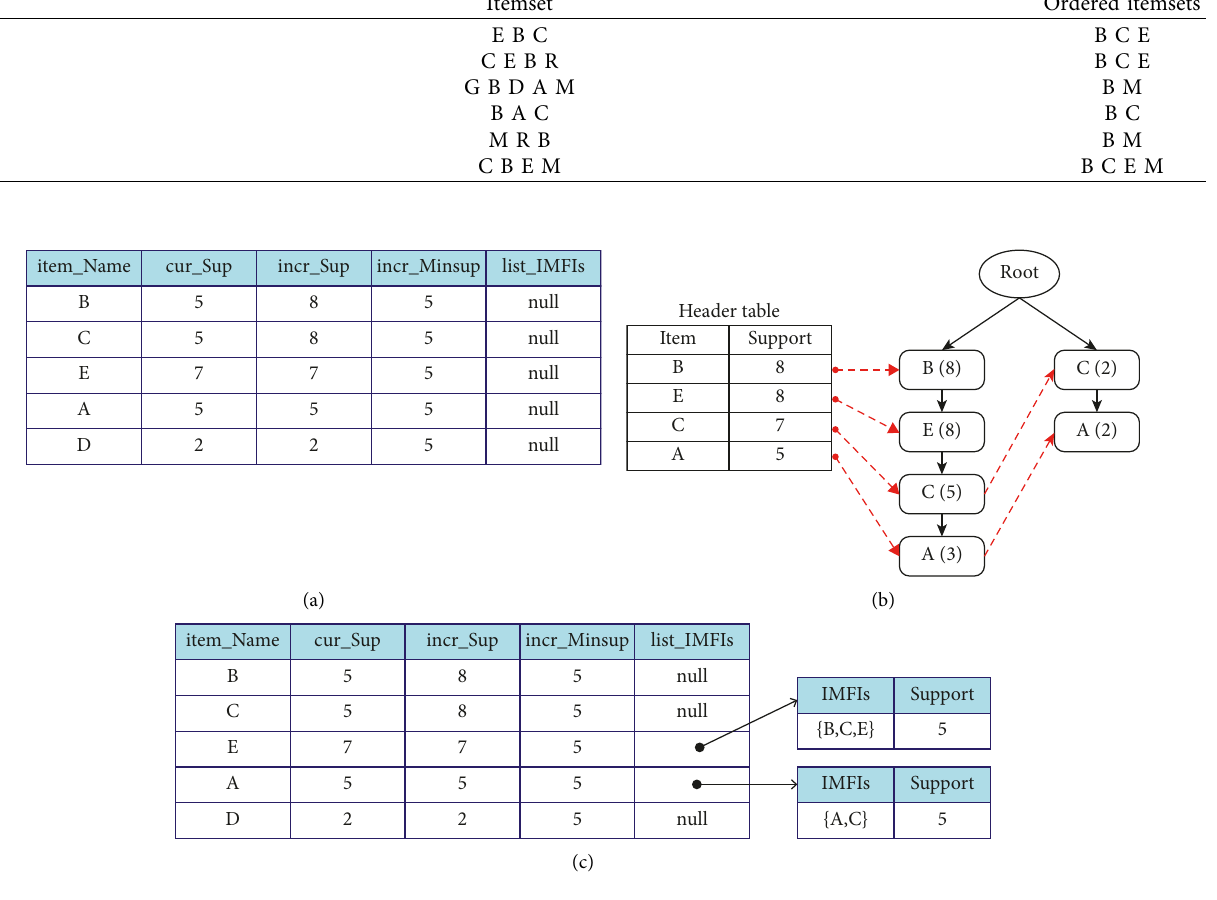
Figure 3: Example at T1. (a) P1 after phase 1, (b) tree as FP-tree after phase 2, and (c) P1 after phases 3-4. Table 8: Rules that have Conf 0.7 after phase 5 at T1. ≥